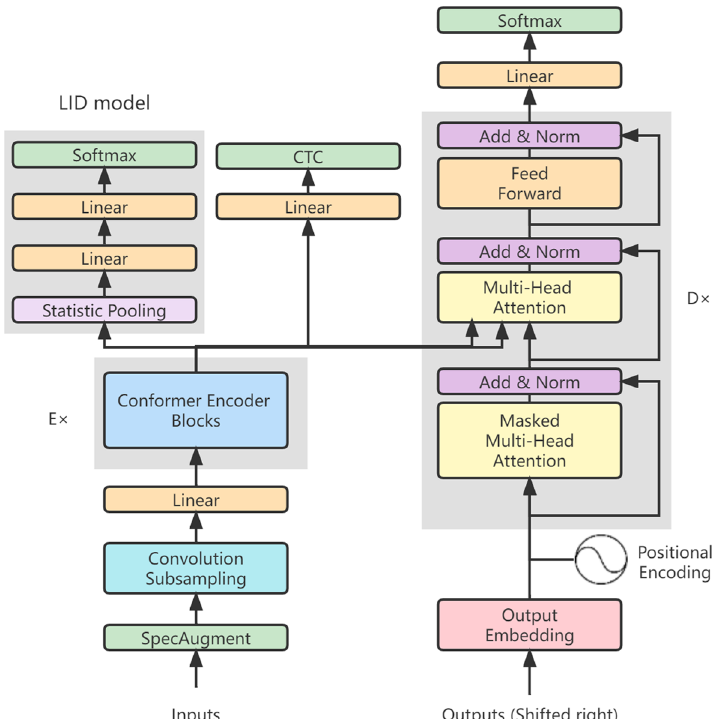
Fig. 5 The architecture of the end-to-end multi-task model